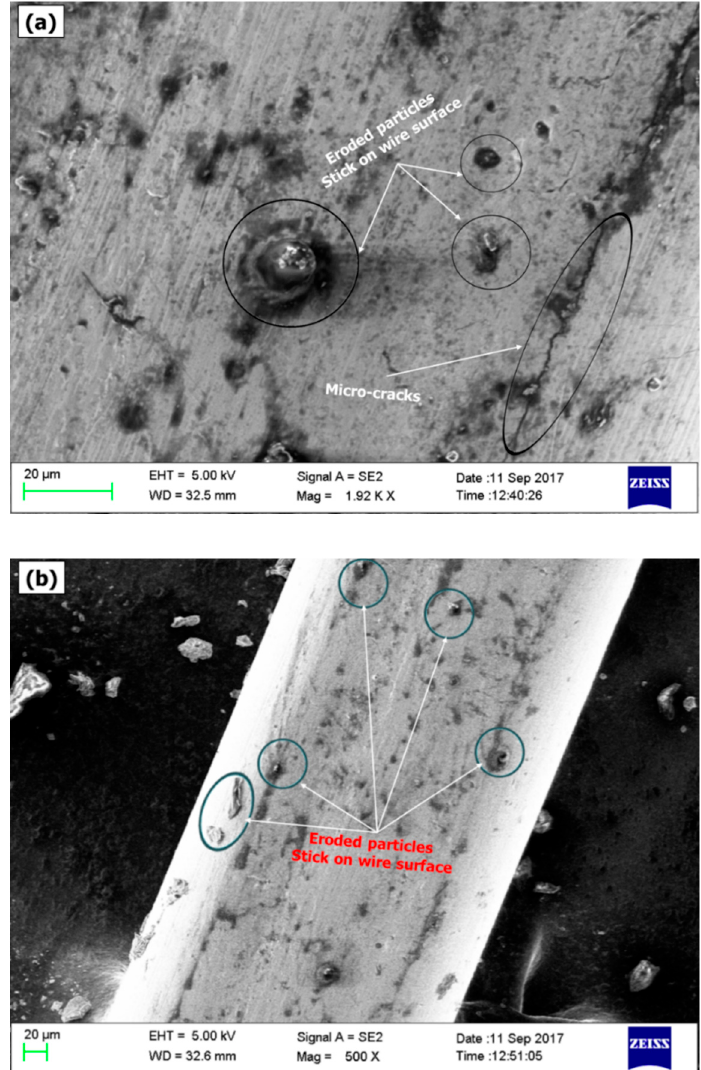
Figure 7. Scanning electron microscope images of the used wire after miniature gear manufactur- ing ( a ) presence of eroded particles and micro-cracks at higher values of pulse-on time; and ( b ) adherence of eroded particles on wire surface at lower values of wire speed.